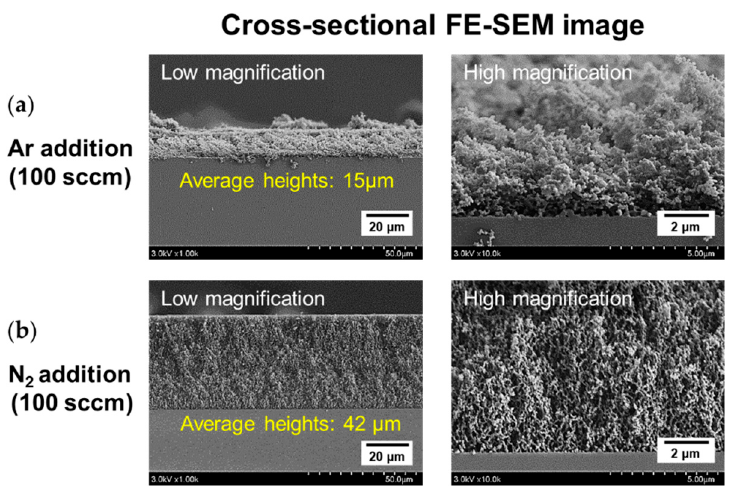
Figure 6. FE-SEM measurements of PANI fi lms synthesized with the addition of ( a ) Ar and ( b ) N 2 (cross-sectional view).